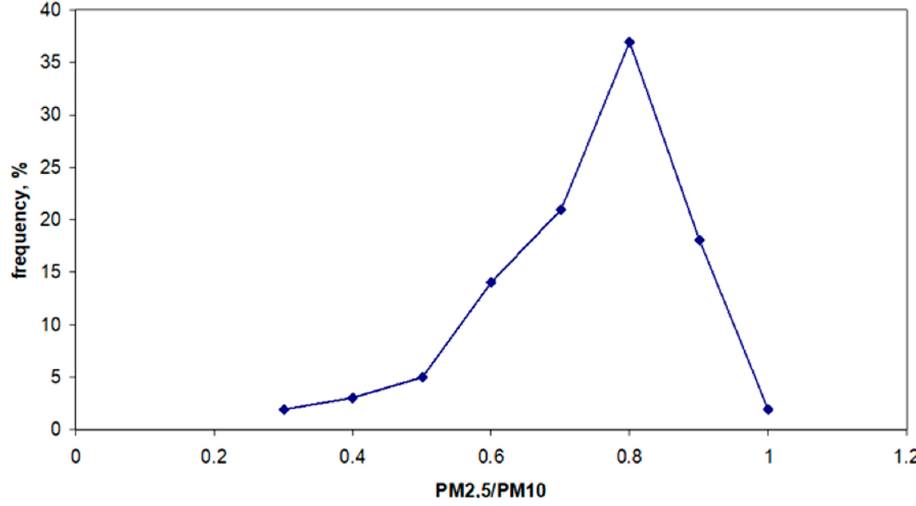
Figure 4. PM 2.5 and PM 10 frequency ratio in Chelyabinsk in autumn ‐ winter season